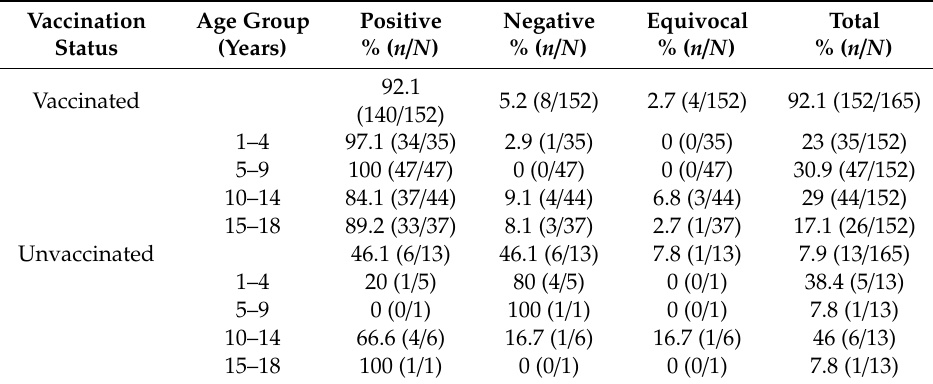
Table 3. Status of the enrolled